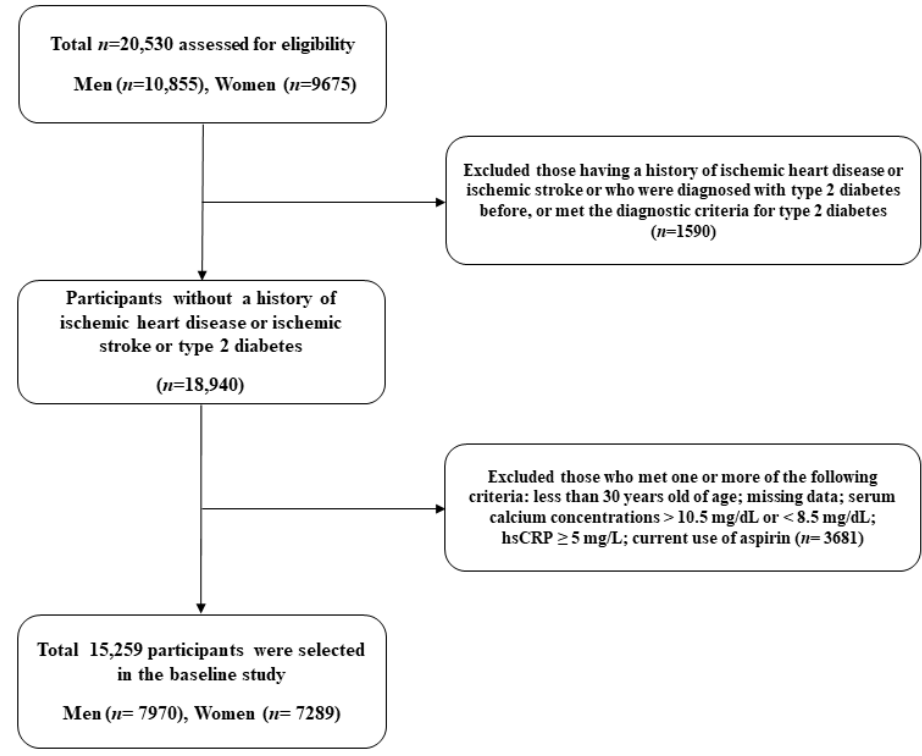
Figure 1. Flowchart for the selection of study participants.